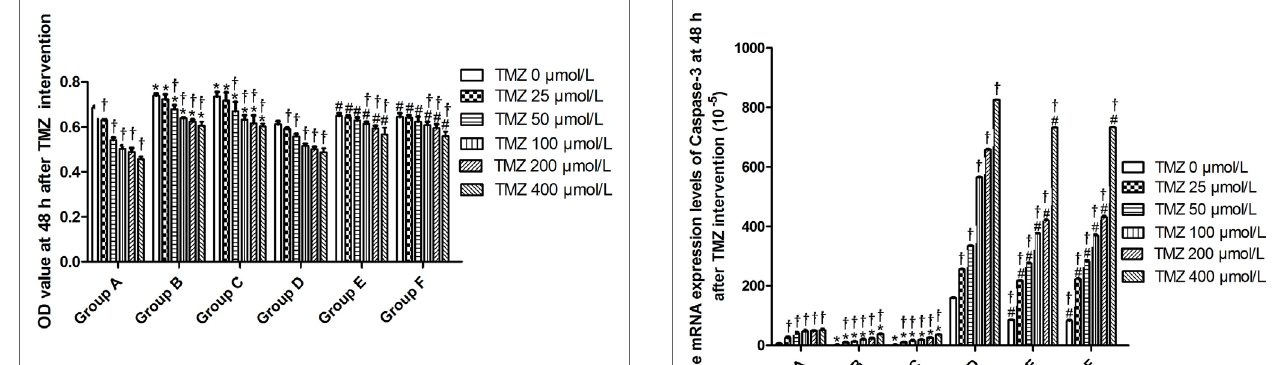
FigUre 3 | The change of OD value at 48 h after temozolomide (TMZ) intervention. * P < 0.05, compared with Group A in the same concentration; † P < 0.05 compared with the concentration of 0 µmol/L; # P < 0.05 compared with Group D in the same concentration. Group A: TJ905 cells transfected with Livin-shRNA, Group B: TJ905 cells transfected with negative-shRNA, Group C: the monolayer culture of TJ905 glioma cells, Group D: glioma stem cells transfected with Livin-shRNA, Group E: glioma stem cells transfected with negative-shRNA, and Group F: the monolayer culture of TJ905 glioma stem cells.